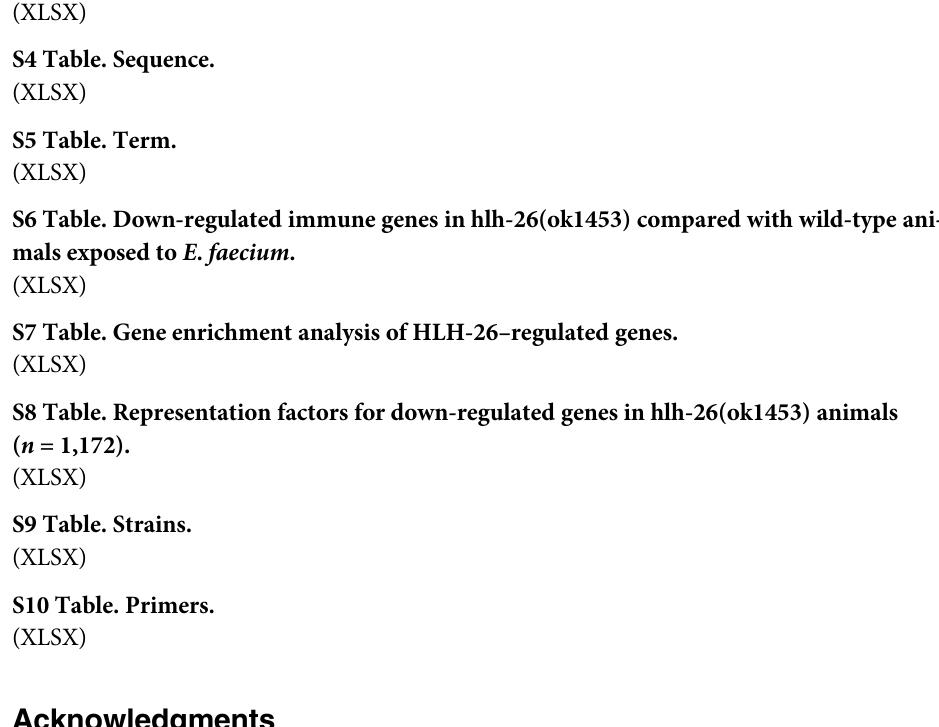
S1 Table. E . faecium –regulated genes that are coexpressed. S2 Table. Common binding motifs for the 30 top ranked coexpressed groups. S3 Table. Genes potentially regulated by top 5 TFs. S4 Table. Sequence. S5 Table. Term. S6 Table. Down-regulated immune genes in hlh-26(ok1453) compared with wild-type ani- mals exposed to E . faecium . S7 Table. Gene enrichment analysis of HLH-26–regulated genes. S8 Table. Representation factors for down-regulated genes in hlh-26(ok1453) animals ( n = 1,172). S9 Table. Strains. S10 Table.